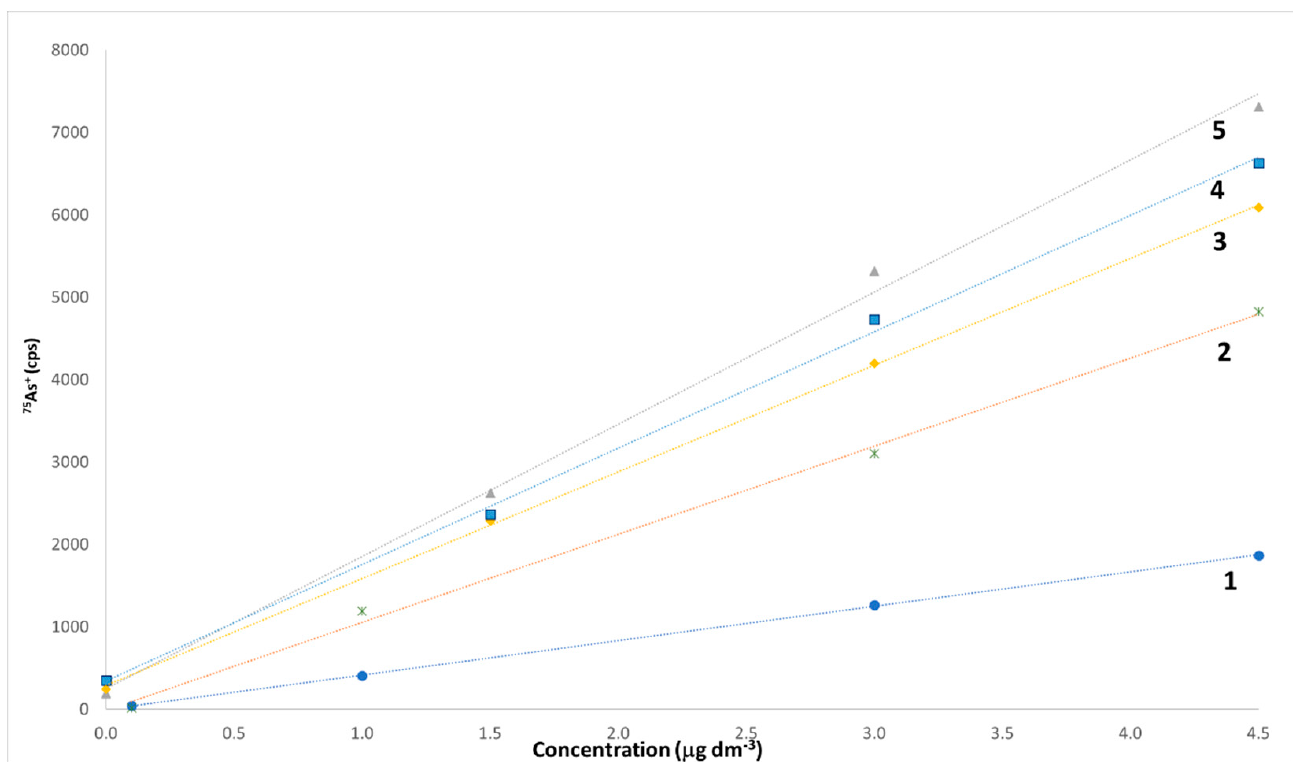
Figure 3. Linear calibration plots obtained using both external and internal calibration for the determination of As. Line 1, external calibration, As concentration in the range between 0.1 and 4.5 µ g dm − 3 in 2% ( v/v ) HNO 3 in water; line 2, external calibration, As concentration in the range between 0.1 and 4.5 µ g dm − 3 in 2% ( v/v ) HNO 3 in synthetic matrix; line 3, internal calibration for a tobacco flavor sample; line 4, internal calibration for a tonic flavor sample; line 5, internal calibration for a fruity flavor sample. In calibration lines 3–5, the amounts of As added to samples are of 113 pg, 226 pg, and 339 pg, respectively.